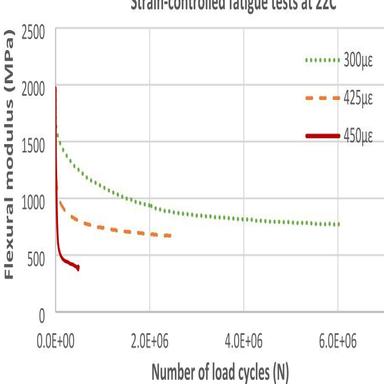
Modulus degradation curves in strain-controlled fatigue tests.